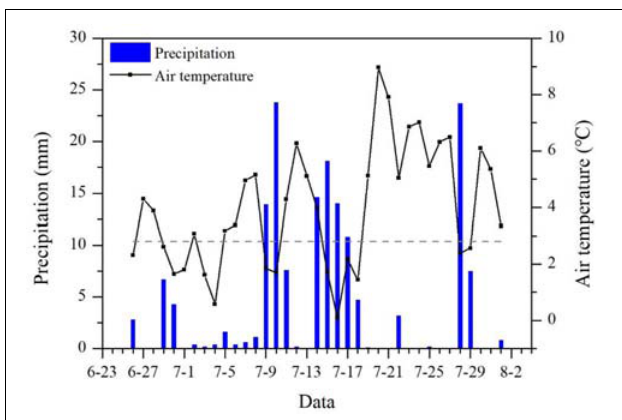
FIGURE 3 | Daily variation of the air temperature and precipitation on Urumqi Glacier No.1 between 26 June and 1 August 2007. The dashed line represented the air temperature threshold of snowfall, which was 2.8 ◦ C. The meteorological data was from the Daxigou station (86 ◦ 50’ E, 43 ◦ 6’ N, elevation: 3593 m a.s.l), which is located 3 km southeast of Urumqi Glacier No. 1.